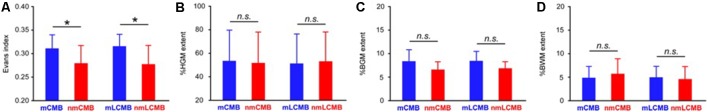
Comparisons of Evans index (EI) and brain atrophy in Alzheimer’s disease (AD) with and without multiple CMB. (A) EI in the multiple CMB group (mCMB) group was significantly larger than that in the non-multiple CMB group (nmCMB) group, and similarly, the multiple lobar CMB group (mLCMB) group was larger than the non-multiple lobar CMB group (nmLCMB) group. There was no significant difference between the mCMB and nmCMB groups or between the mLCMB and nmLCMB groups in (B) percentage of hippocampal gray matter atrophy (% HGM), (C) whole-brain gray matter atrophy (% BGM), or (D) whole-brain white matter atrophy (% BWM). The results suggest that AD with multiple CMB exhibit significantly enlarged lateral ventricles compared to AD without multiple CMB, whereas no significant difference in brain atrophy was found between groups. Asterisks indicate significant differences (p < 0.05). Error bars indicate SD. n.s., not significant.